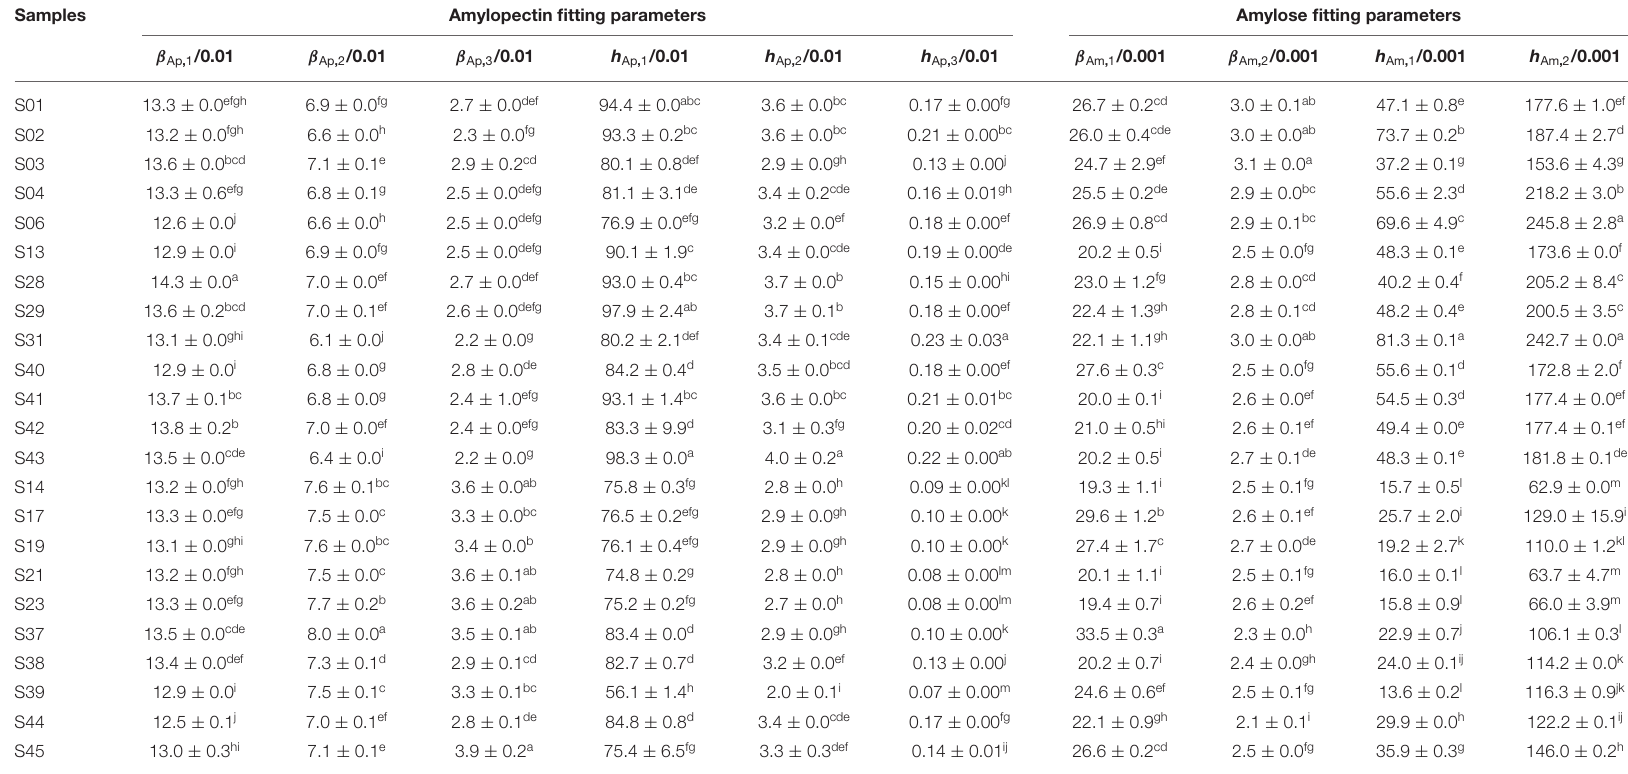
Mean ± standard deviation is calculated from duplicate measurements; values with different letters in the same column are significantly different at p <